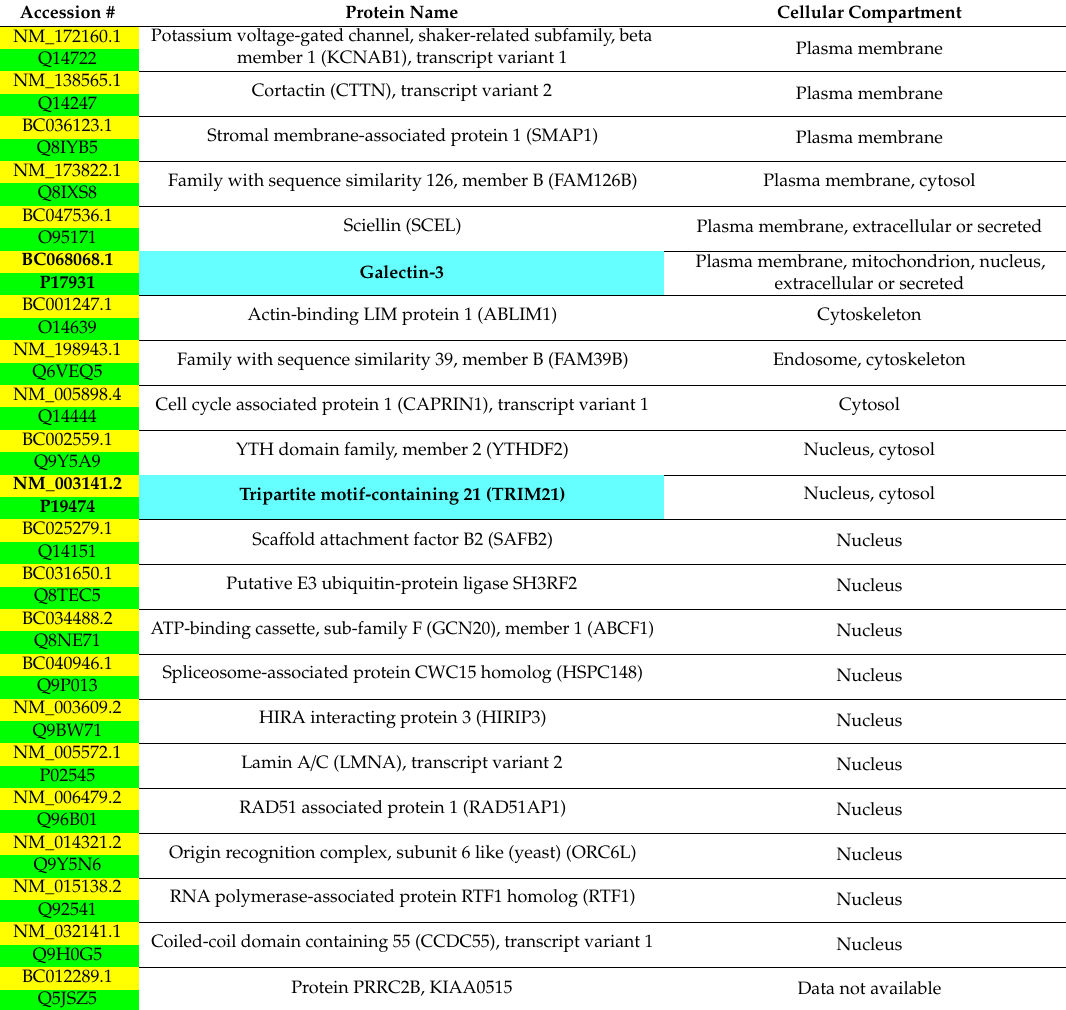
Table 1. Human protein-array analysis of endoglin interactors 1